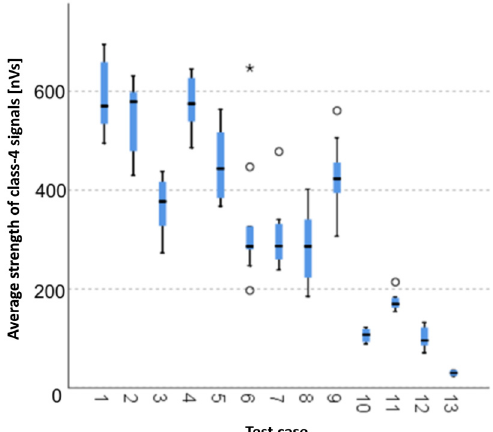
Figure 12. Graphic presentation of the Kruskal–Wallis test results for independent samples: average strength of class-4 signals.